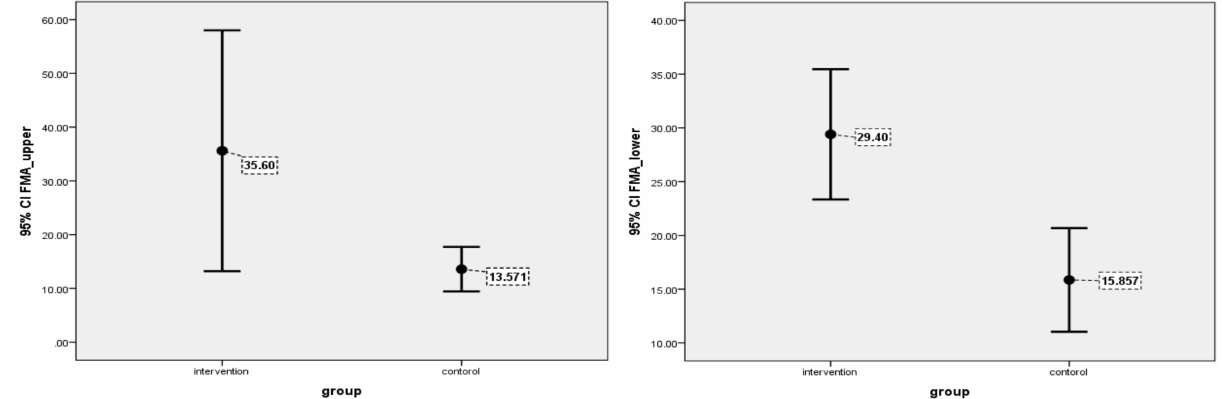
Figure 3. Error bars plots showing result of Fugl-Meyer Upper & Lower function between two